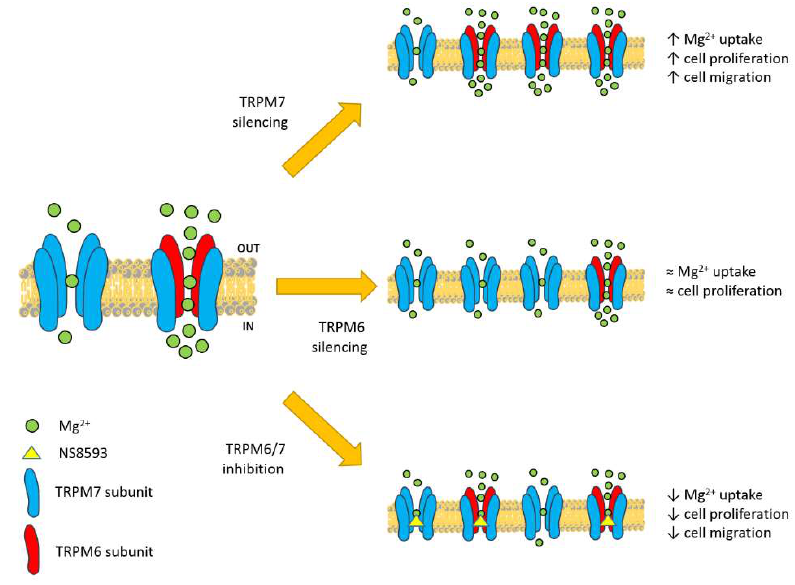
Figure 6. Suggested model for the role of TRPM6 in intestinal Mg absorption. Colon cancer cells express both TRPM7 and TRPM6, which can assemble into functional homomers or heteromers at the plasma membrane (left). The different regulation of TRPM7 and TRPM6/7 channels in physiological conditions determines higher Mg 2+ fluxes through TRPM6/7 heteromers. Thus, the ratio between differently assorted tetramers affects cation influx and related signaling pathways (right panels). Partial TRPM7 silencing favors formation of TRPM6/7 channels, thereby increasing Mg 2+ influx, and consequently cell proliferation and migration (upper right panel). In turn, partial TRPM6 knocking-down promotes assembly of TRPM7 homomers, which sustain basal Mg 2+ influx and proliferation (middle right panel). Pharmacological inhibition of assembled channels decreases overall Mg 2+ influx, and downstream functions (lower middle panel).